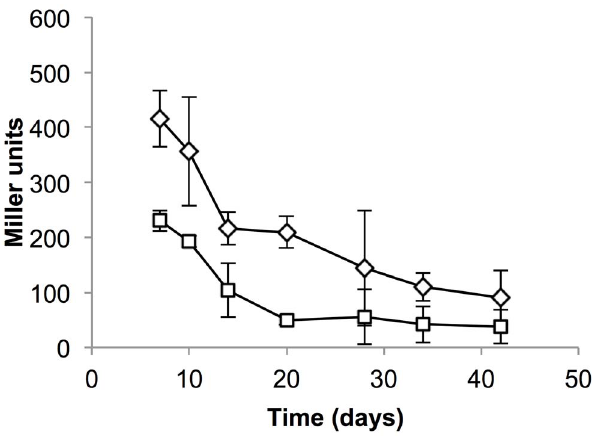
Figure 1. mbtB and mbtI promoters are induced in response to oxygen depletion in M.tuberculosis . P mbtB and P mbtI activity was measured as b -galactosidase activity from a LacZ reporter in cell-free extracts. Bacteria were cultured in the Wayne model of hypoxia. Diamond – mbtB ; square – mbtI . Data are the mean and standard deviation from three independent transformations.